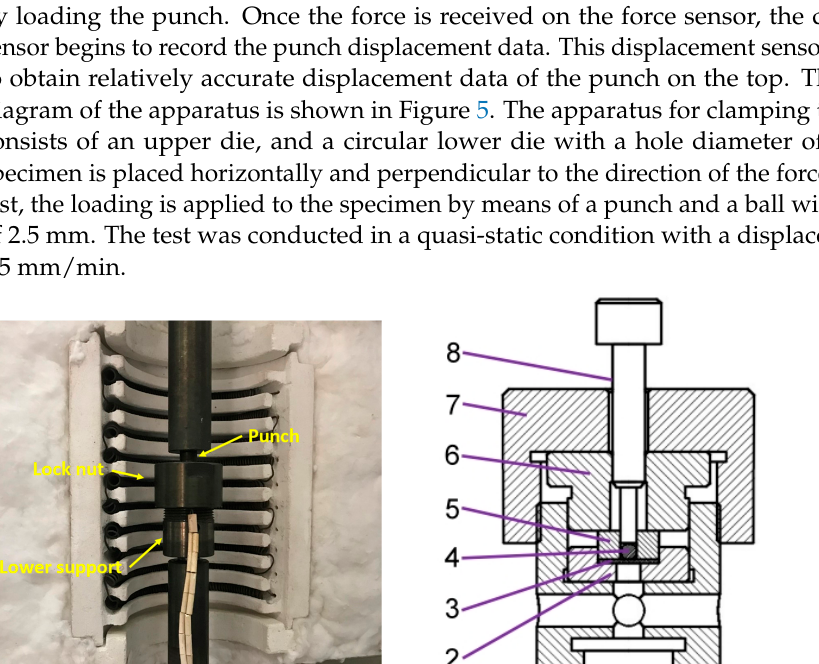
Figure 4. Macro morphology of a small punch specimen. ( a ) before test; ( b ) after test.